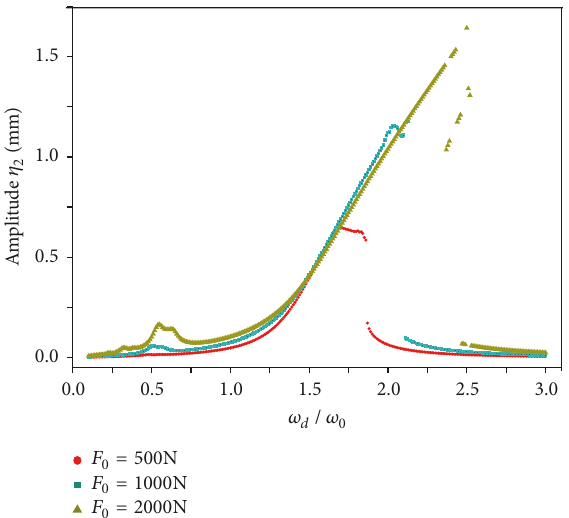
Figure 11: Amplitude-frequency curves related to 𝜂 2 for different excitation amplitudes ( 𝑚 = 1 , 𝑛 = 5 ; Ω = 0.005